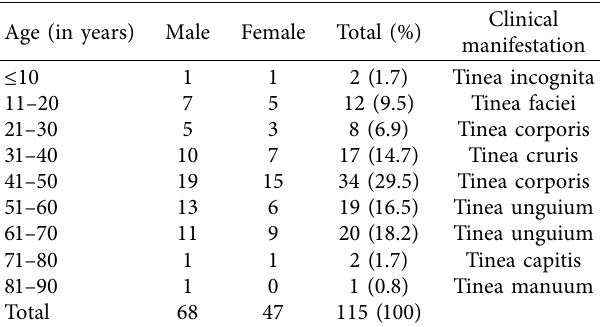
Table 2: Age and sex-wise distribution of participants based on clinical manifestation.